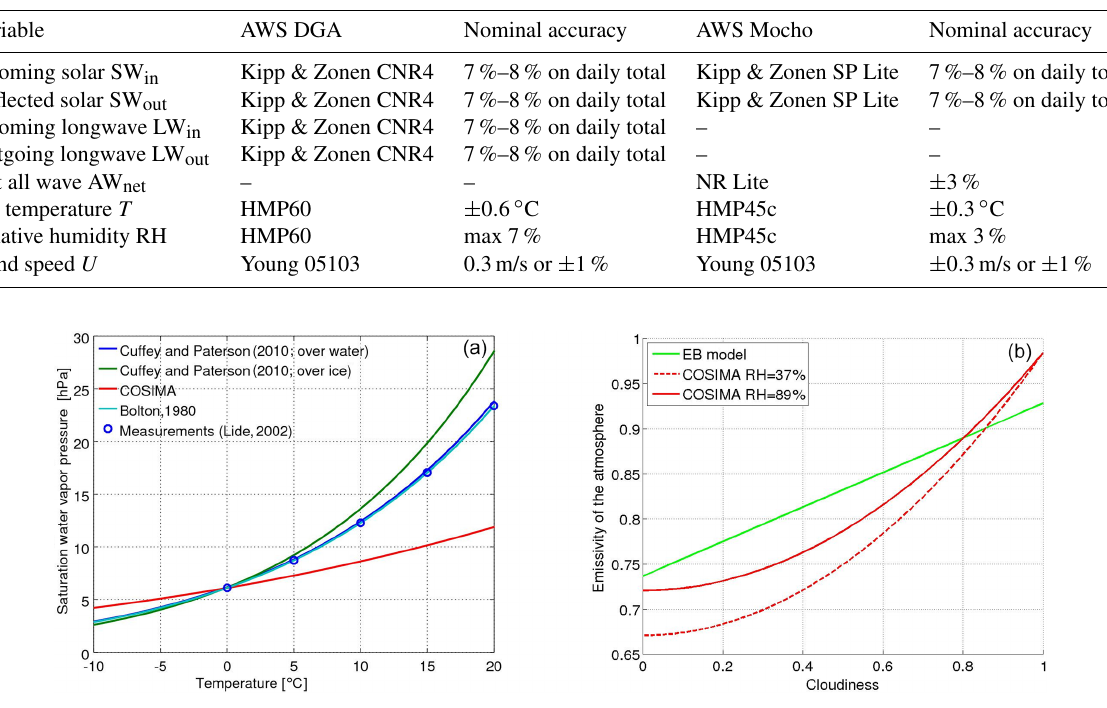
Figure 3. (a) Different parametrizations of the saturation vapor pressure as a function of the air temperature found in the literature; we chose the parametrization of Bolton (1980). (b) Emissivity of the atmosphere as a function of the cloud cover as implemented in the EB model and COSIMA.